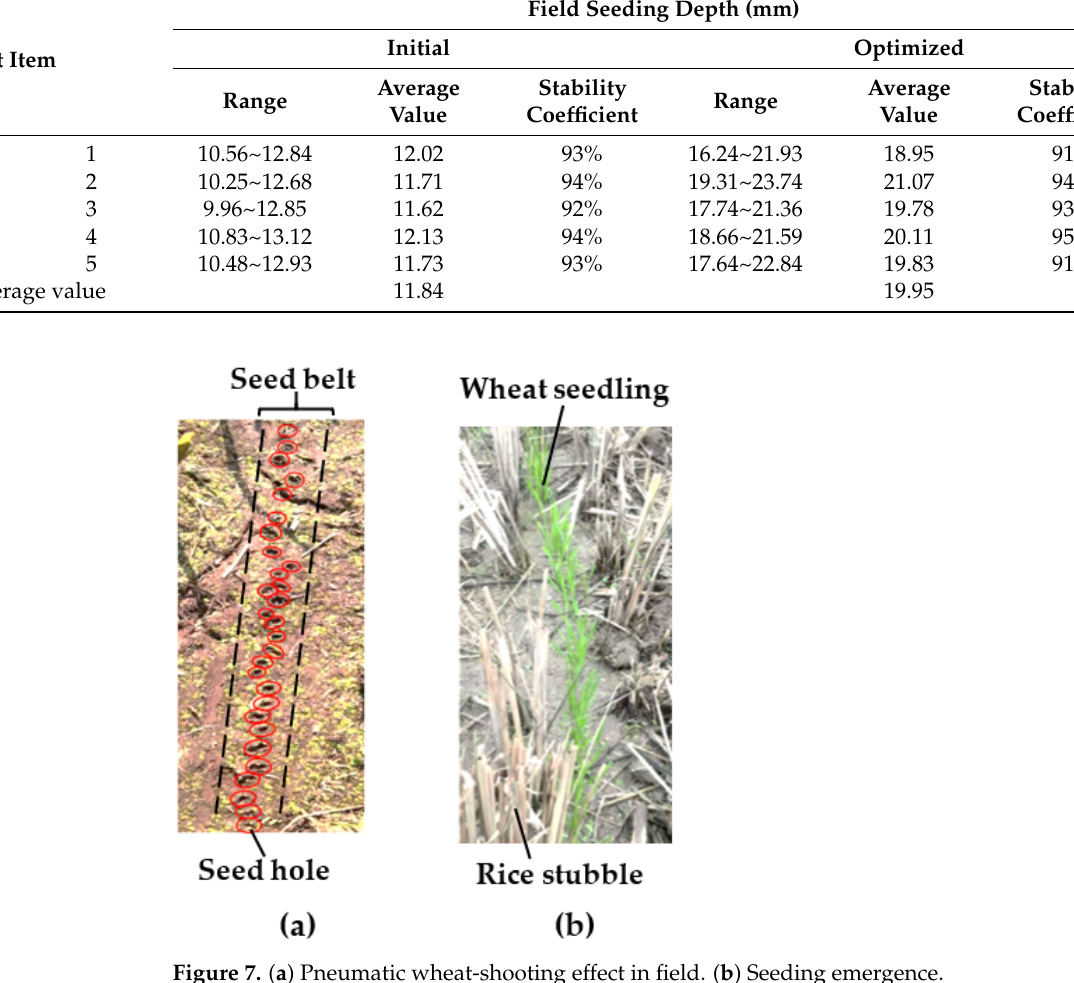
Table 5. Field seeding depth for initial and optimized pneumatic wheat-shooting device.